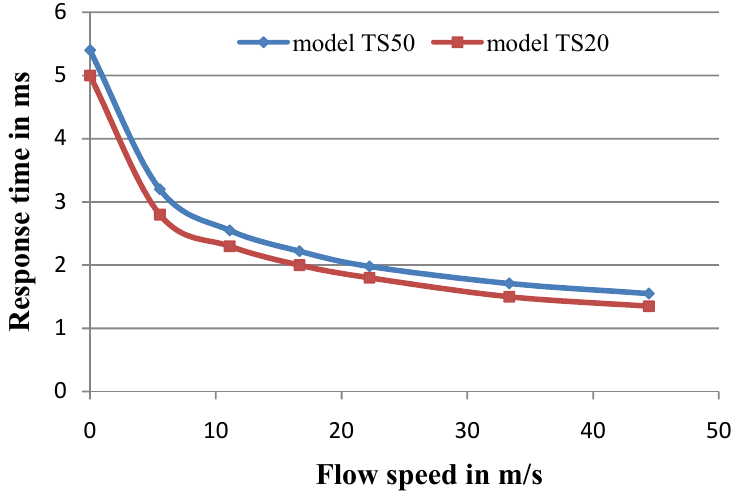
Figure 6. Comparison in response time between two sensor configurations TS20 and TS50. Dots are model results for some discrete values of velocity and lines are the splines